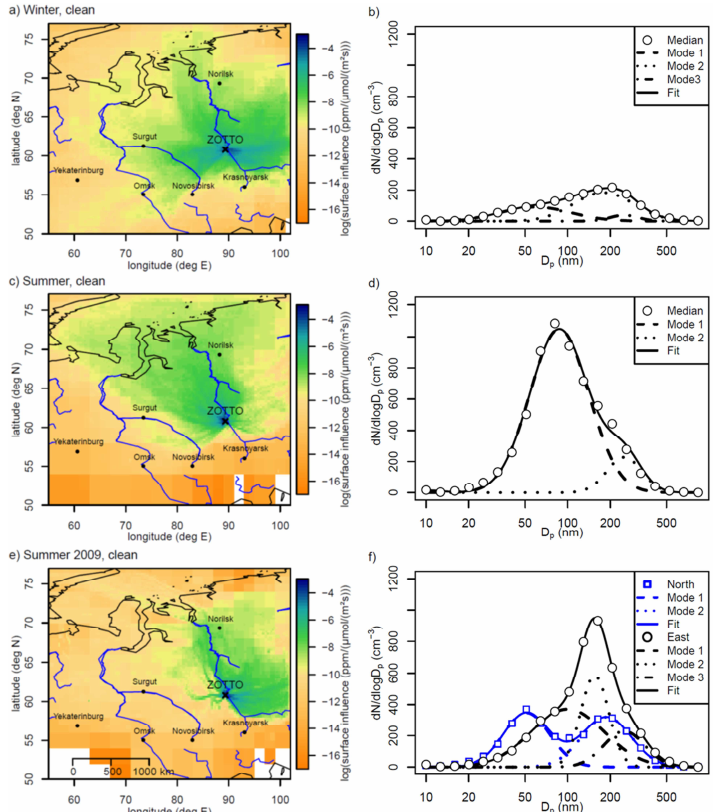
Figure 11: Footprint and median aerosol number size distribution of clean air periods: a-b) during winter, c-d) during summer 2006-2008, e-f) during summer 2009. Fig. 11. Footprint and median aerosol number size distribution of clean air periods: (a–b) during winter, (c–d) during summer 2006–2008, (e–f) during summer